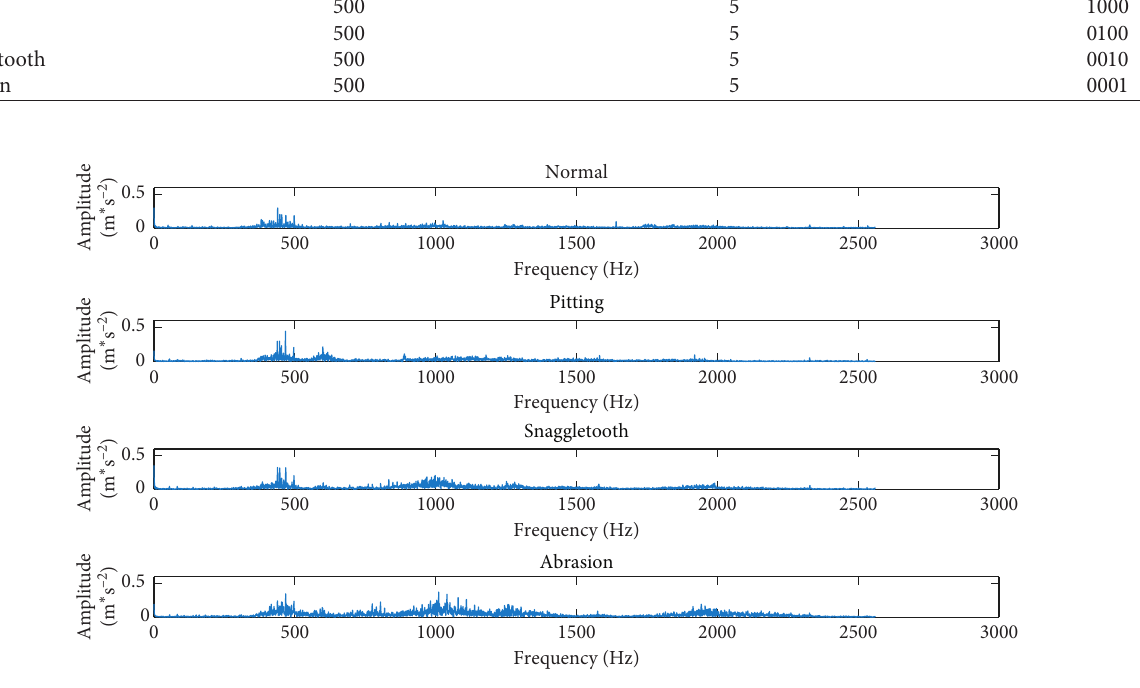
Figure 5: FFT spectrum of different running states. Table 2: Parameter setting of